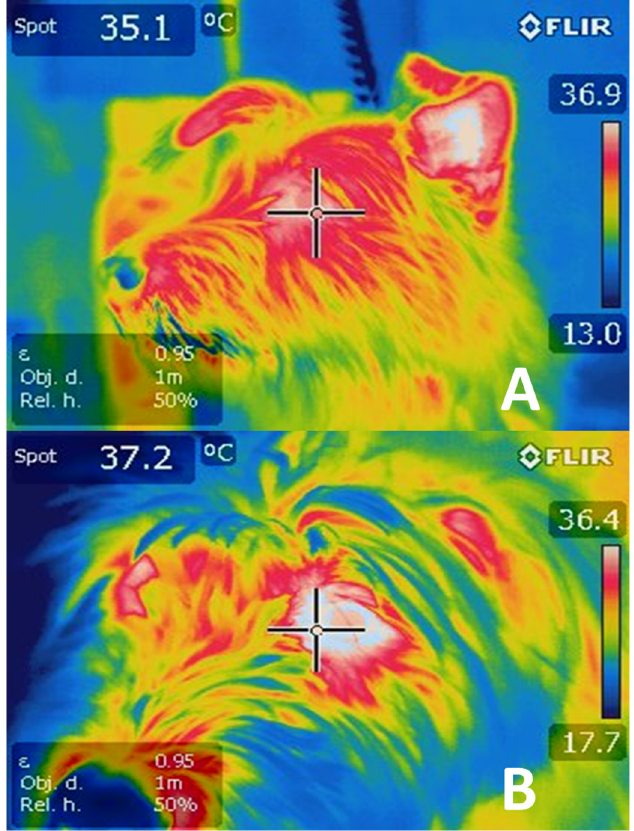
Figure 5. Thermograms of an idle dog ( A ) vs. a dog doing exercise ( B ). During repose ( A ), the ocular temperature was 35.1 °C, compared to image (B showing an ocular temperature of 37.2 °C in a dog after 15 min of exercise. (Obtained with an FLIR E 50 camera with an 18-mm FOL lens at a resolution of 240 × 180 pixels, (emissivity = 0.95, distance = 1 m)).